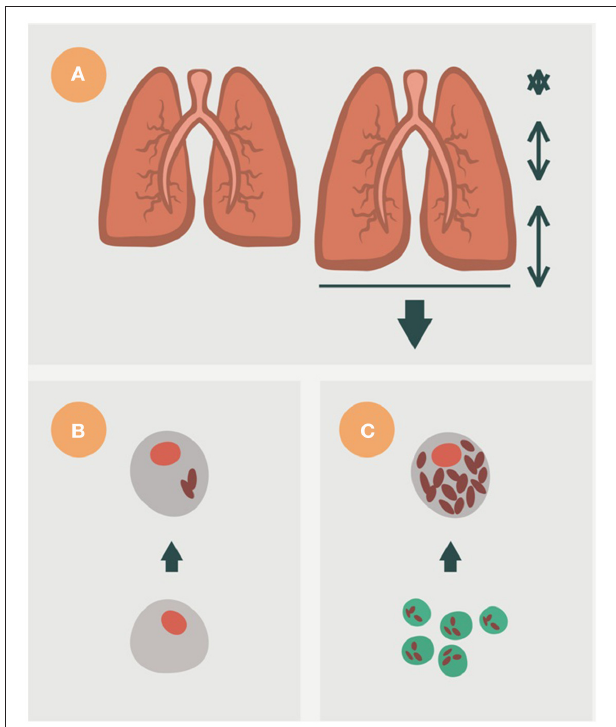
FIGURE 6 | Importance of breathing amplitude in the lung, for the induction of active TB. In mammals, breathing in, or inhaling, occurs due to the contraction and flattening of the diaphragm, a domed muscle that separates the thorax and abdomen (A) . This action increases the space of the alveoli, although not homogeneously. The lobes of the base experience the largest amplitude, whereas the upper lobes experience almost no movement. This fact has a major consequence, namely a very important drainage of bacilli after destruction of the alveolar macrophage (AM) toward neighboring alveoli in the base, with almost none at the upper lobes. This means that new AMs face a lower bacillary load in the base than in the upper lobes (B) . The increase of the bacillary load stimulates necrosis and neutrophilic infiltration (C) . This hypothesis can explain why the evolution toward active TB mainly occurs in the upper